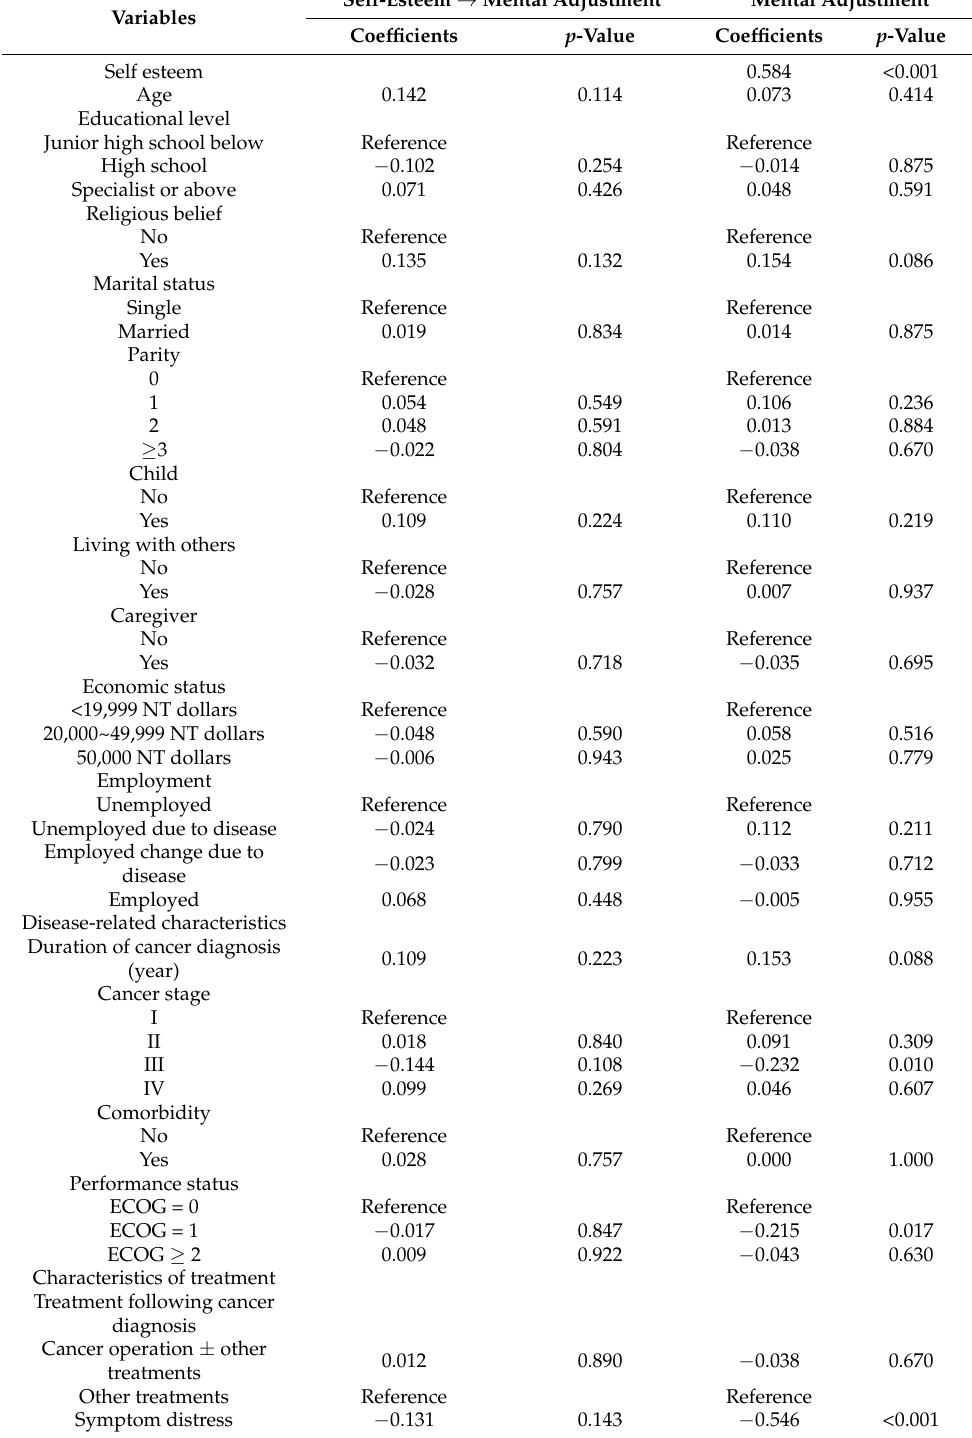
Table 4. Path modeling of self-esteem and mental adjustment in breast cancer patients ( n =